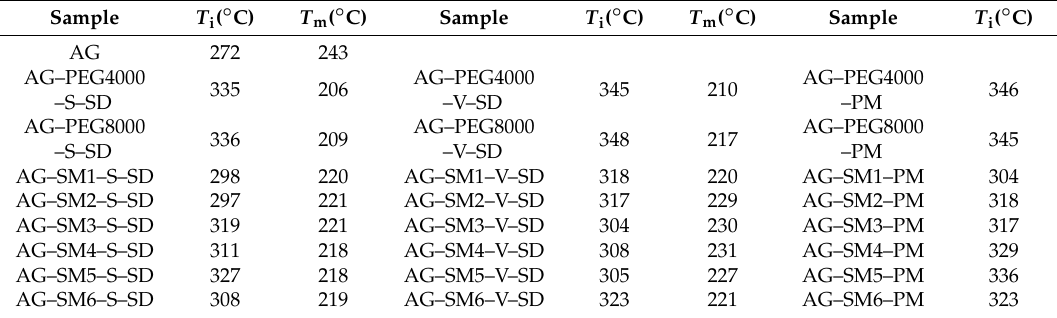
Table 2. T i (5% weight-loss temperature) and T m (melting temperature) of pure andrographolide (AG), physical mixture (PM), and solid dispersion